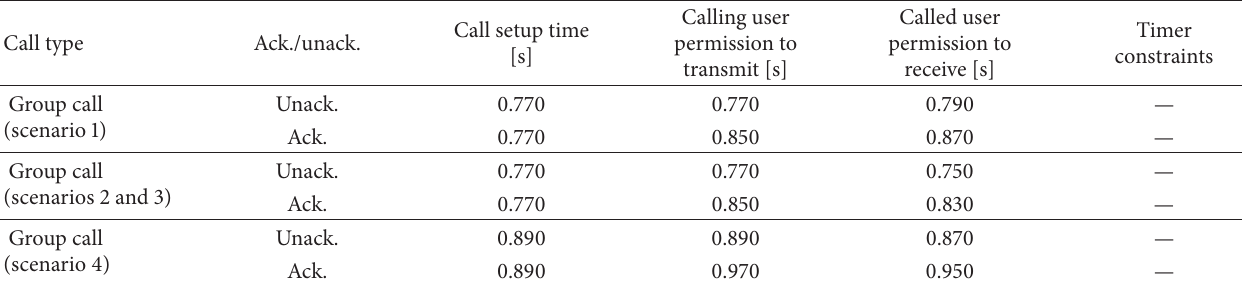
Figure 10: A-bis information flow sequence with PEPs, group call scenario 4. Table 5: A-bis backhauled TETRA call setup times using